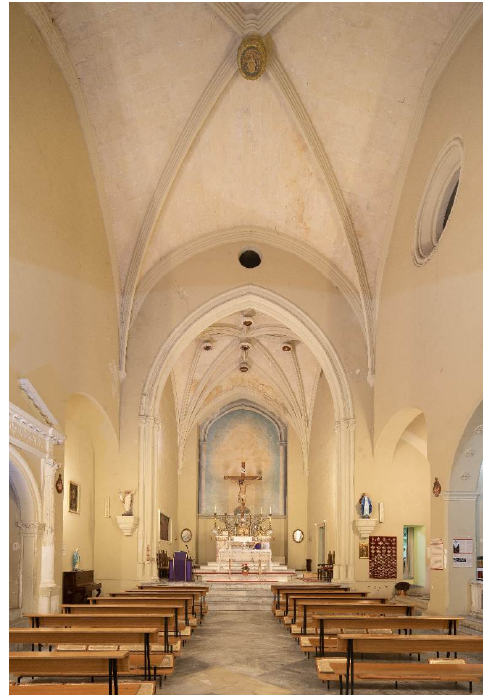
Figure 6 . A view of the nave and presbytery of the Church of Santa Lucia.